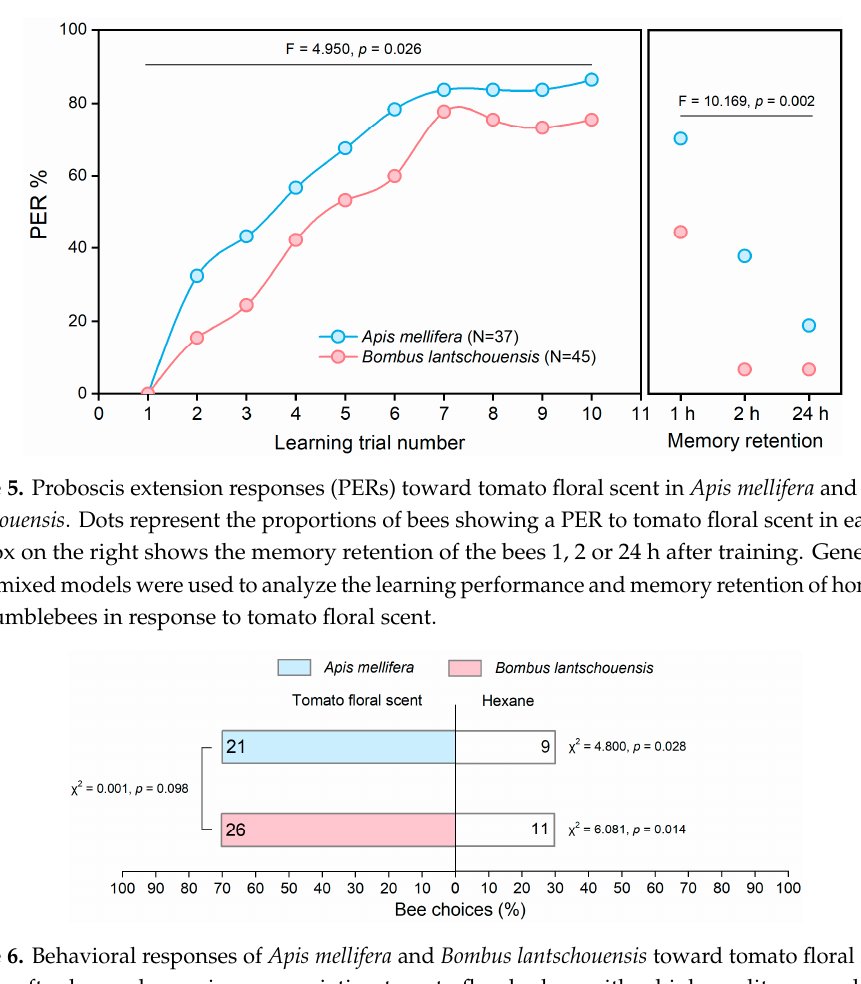
9 of 15 Figure 4. Behavioral responses of Apis mellifera and Bombus lantschouensis to tomato floral scent in Y- tube olfactometer. ( A ) Naïve bees from colonies that had never been used to pollinate tomato planted in a greenhouse or outside; ( B ) Bees from colonies in tomato greenhouses. The numbers in each bar represent the numbers of bees that made a choice. A one-sample chi-square test was used to analyze whether significant differences existed in bee choices between tomato floral scent and hexane. Pearson’s chi-square test was used to analyze the influence of foraging experience on the choice of the bees and to compare the differences in choice between the two bee species. 3.3. Influence of Learned Experience on Bee Response to Tomato Floral Scent The learned experience of associating scent with a food reward influenced the responses of both